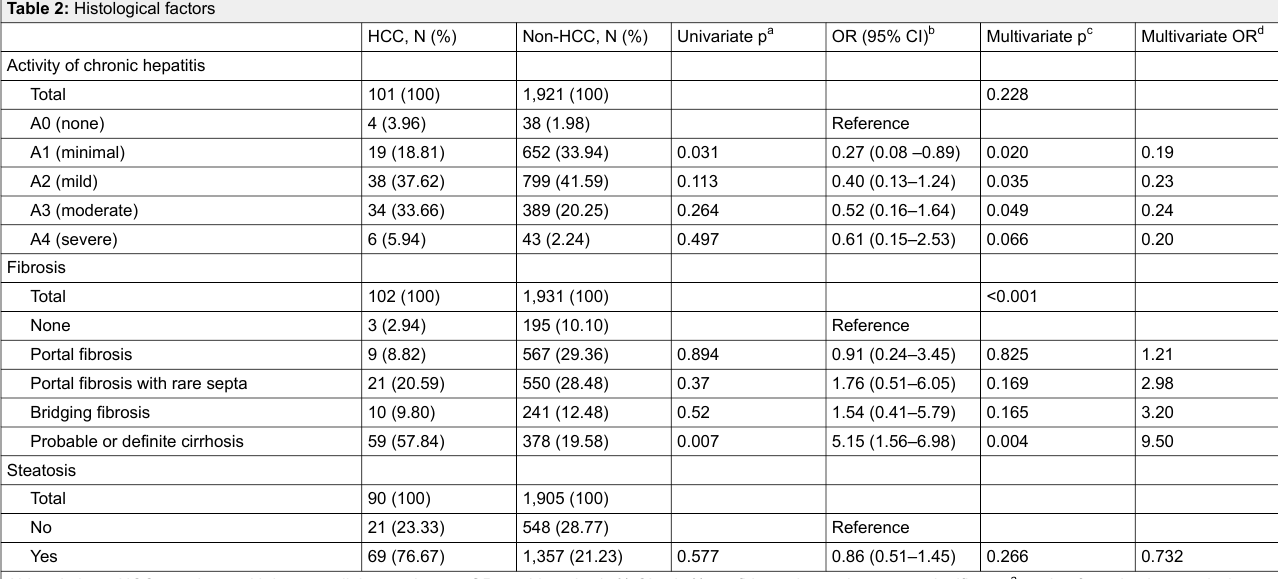
Table 2: Histological factors